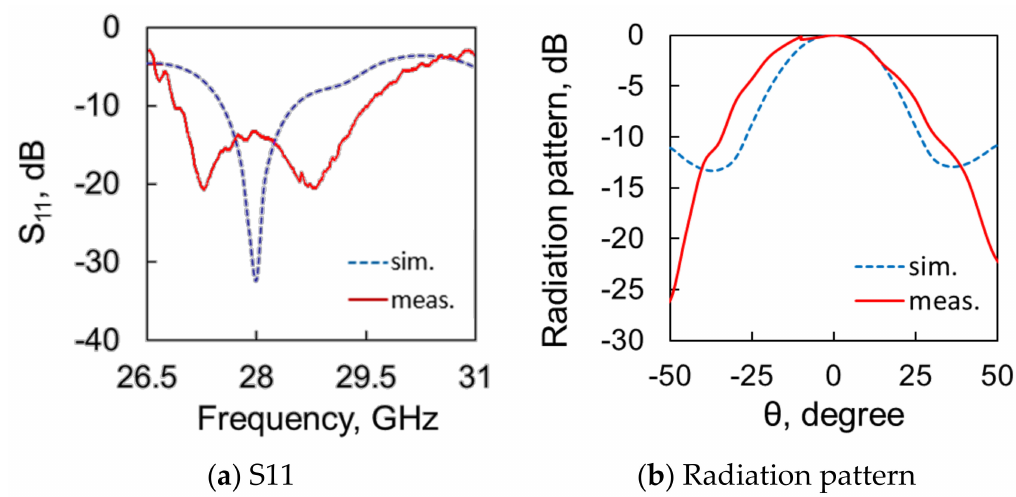
Figure 6. 28 GHz rectenna: ( a ) antenna and ( b ) rectifier.